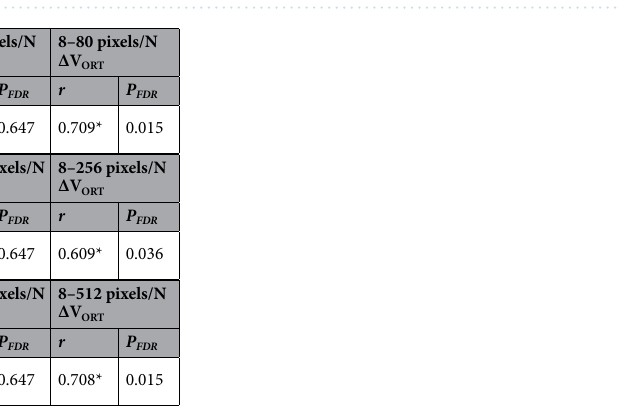
Figure 4. Correlation findings between changes in V ORT and RMSE from the lowest to three higher visual gain conditions. ( A ) Δ in V ORT versus Δ in RMSE from 8 to 80 pixels/N. ( B ) Δ in V ORT versus Δ in RMSE from 8 to 256 pixels/N. ( C ) Δ in V ORT versus Δ in RMSE from 8 to 512 pixels/N. Note that P FDR indicates P value corrected by a false discovery rate.